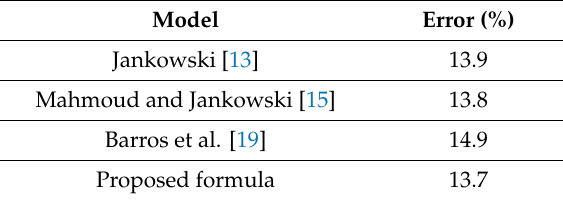
Table 2. Errors between experimental and numerical results for the impact force time